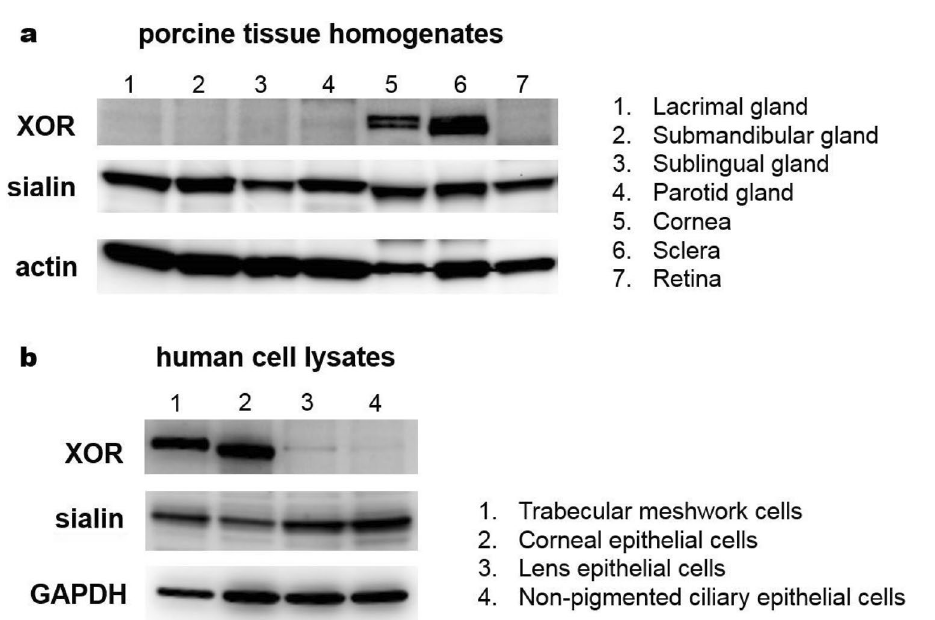
Figure 3. Analyses of nitrate metabolism-related proteins by Western blotting. Protein samples (50 μg) were run on SDS-PAGE and transferred onto nitrocellulose membranes for immunoblotting. Primary antibodies (anti-XOR, -sialin, -actin and -GAPDH) were incubated overnight at 4 °C and then secondary antibodies conjugated with horseradish peroxidase were used for the enhanced chemiluminescence detection. The uncropped image of the Western blot is presented on Supplementary